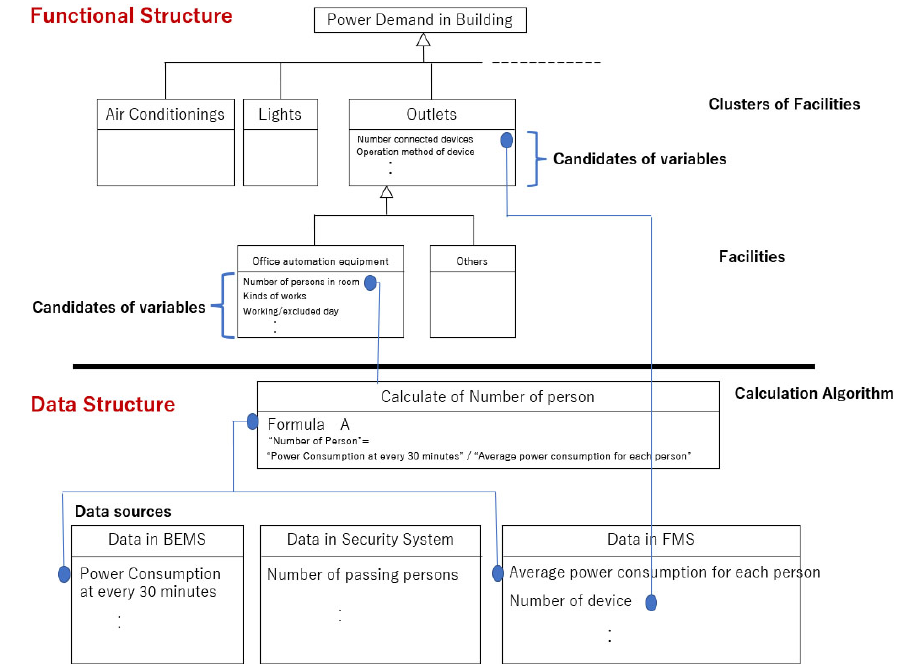
Figure 2. Overview of the Extended Goal Graph (EGG).